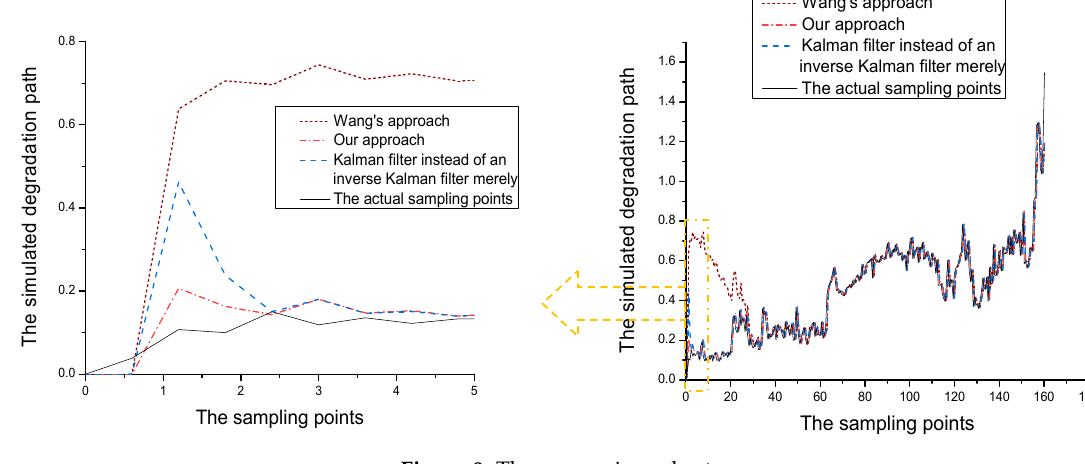
Figure 8. The comparison chart.